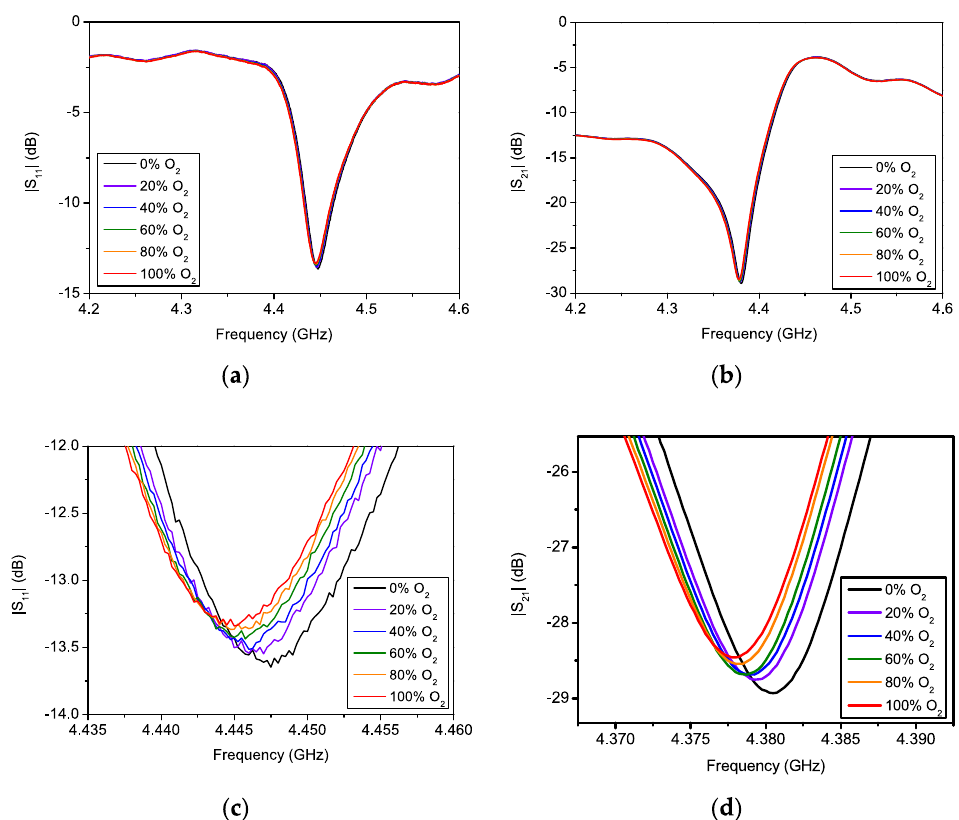
Figure 5. Magnitude of S 11 ( a , c ) and S 21 ( b , d ) versus frequency for six different O 2 concentrations, ranging from 0% O 2 to 100% O 2 . The selected frequency range goes from 4.2 GHz to 4.6 GHz.